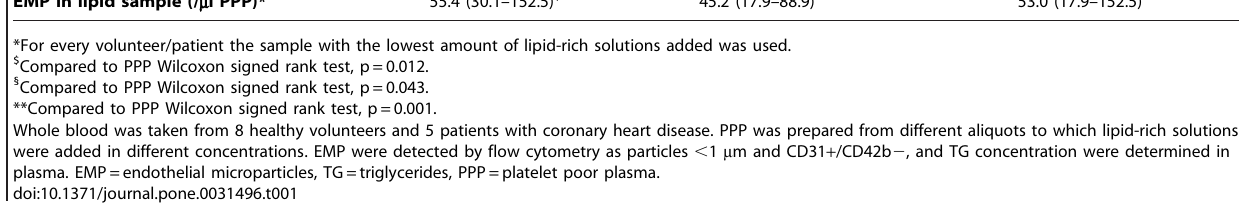
Healthy controls (N=8) Cardiovascular patients